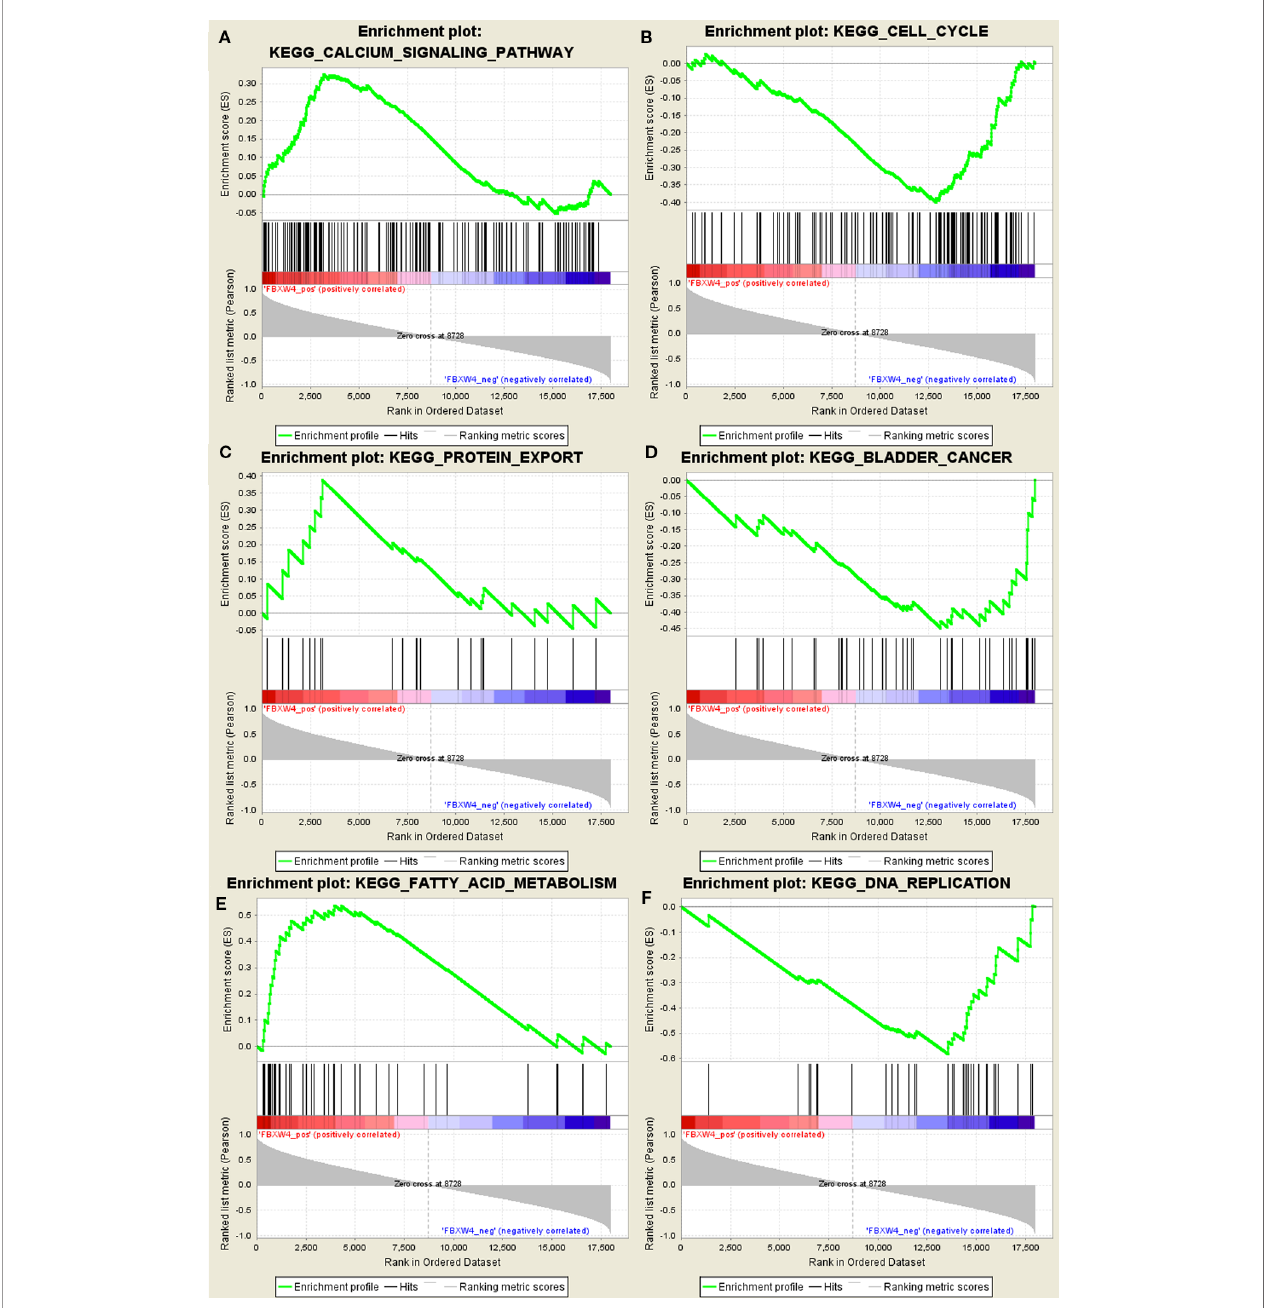
FIGURE 6 | GSEA using our data. (A) Calcium signal pathway. (B) Cell cycle. (C) Protein export. (D) Bladder cancer. (E) Fatty acid metabolism. (F) DNA replication signal